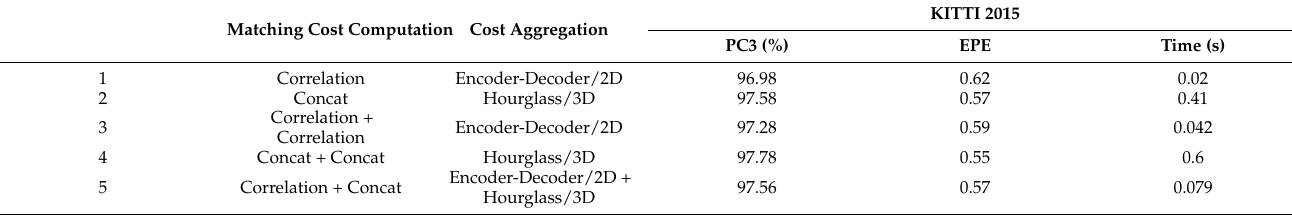
Table 5. Evaluation of JDCNet with different settings. We use 182 stereo images of KITTI 2015 for training and remaining 12 images for testing. We select PC3, EPE and running time as the evaluation metrics, where PC3 denote the percentage of three pixel error of all valid pixels, EPE and running time have been introducted in Section